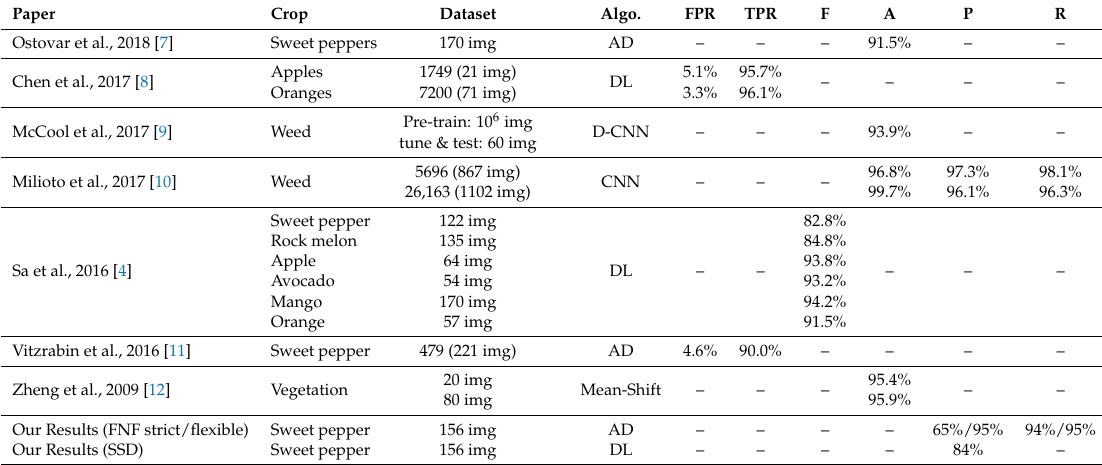
Table 1. Summary of previously published results and comparison to proposed